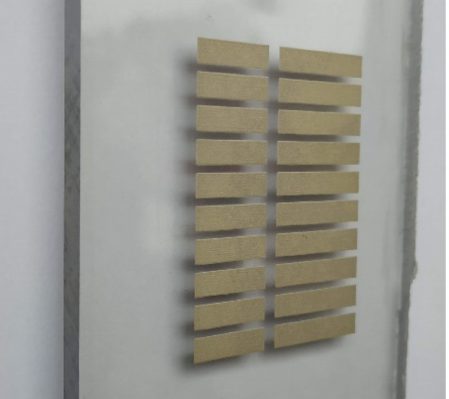
Figure 28. Photograph of a quasi-absolute 10-bit encoder implemented on polycarbonate. Patch dimensions are those indicated in Figure 25.